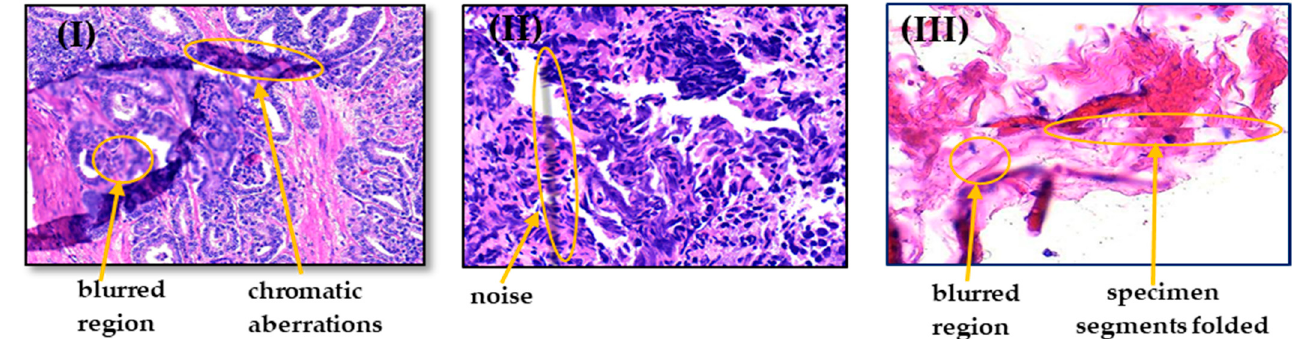
Figure 4. Examples of possible artifacts in histopathological images, where ( I ) contains chromatic aberrations and blurred regions; ( II ) contains noise, and ( III ) contains specimen segments folded and blurred regions.